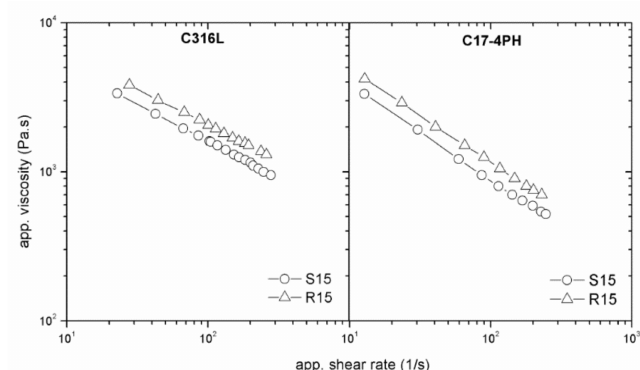
Figure 6. Effect of surface roughness on flow properties of stainless-steel powders 316L (C316L) and 17-4PH (C17-4PH) in catalytic polyacetal Catamold binder system (C).